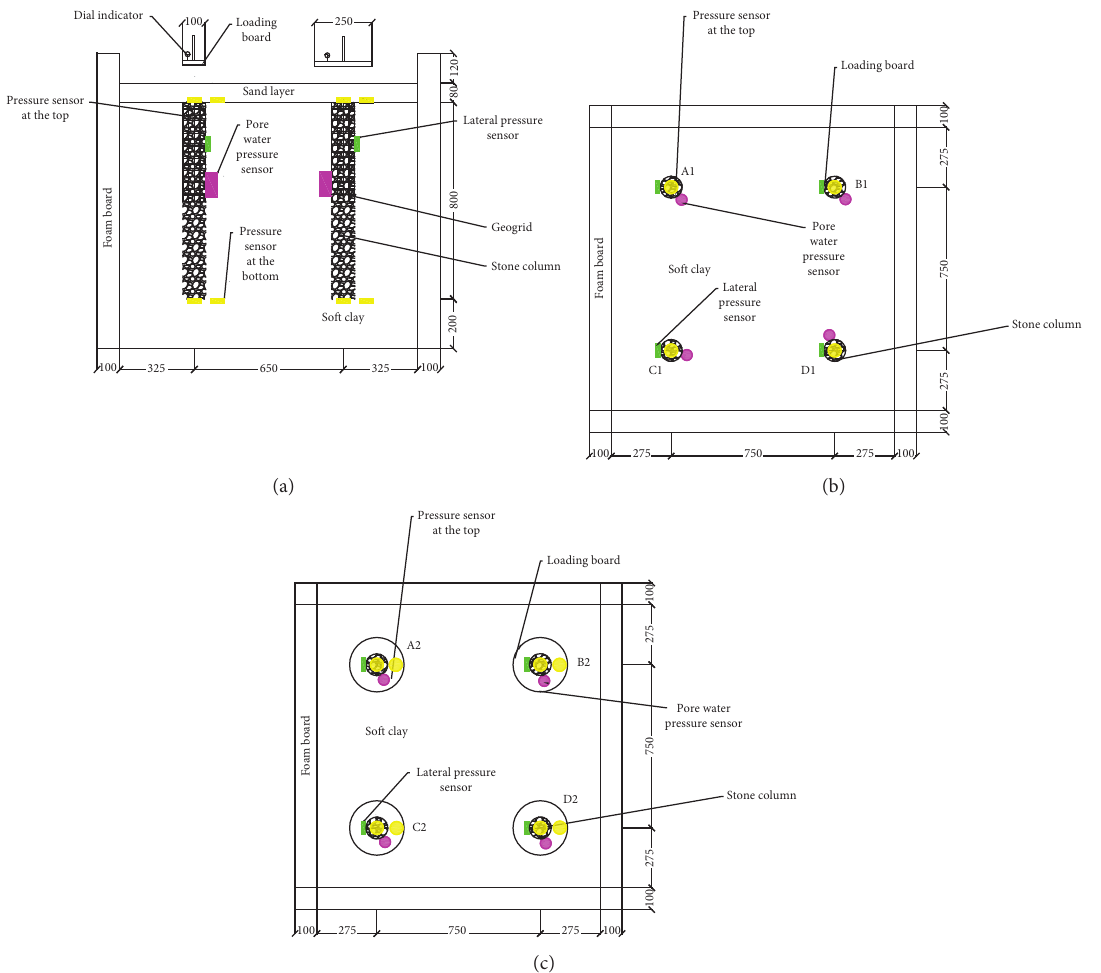
Figure 4: Load tests on the models. (a) Single column, (b) plan view of a single column, and (c) plan view of a single column composite foundation.